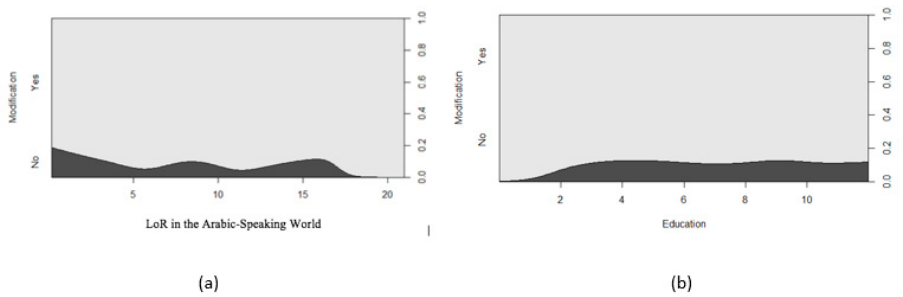
Figure 7. The effects of LoR ( a ) and L1 schooling ( b ) on FDH’s production accuracy of onset CCs.